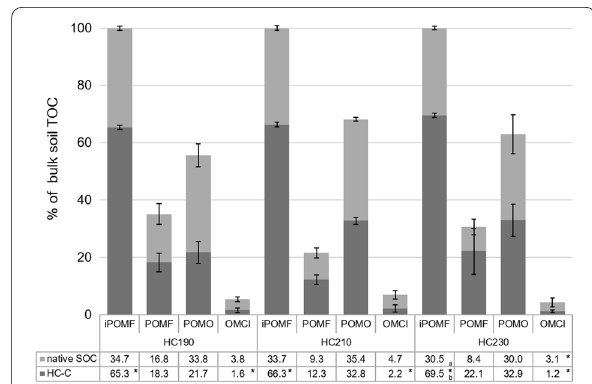
Fig. 3 The average percent (%) carbon (C) derived from the different temperature hydrochars (HC-C) relative to the native soil organic carbon (SOC) content within the major soil organic matter (SOM) fractions at the beginning of the study (as iPOM F ), and after approx. 1 year of soil incubation (as POM F , POM O and OM Cl ). Error bars represent standard deviation of the means. Different letters indicate significant differences ( p < 0.05) in means between HC-C and native SOC within fractions. An asterisk (*) indicates significant differences ( p < 0.05) in means between HC